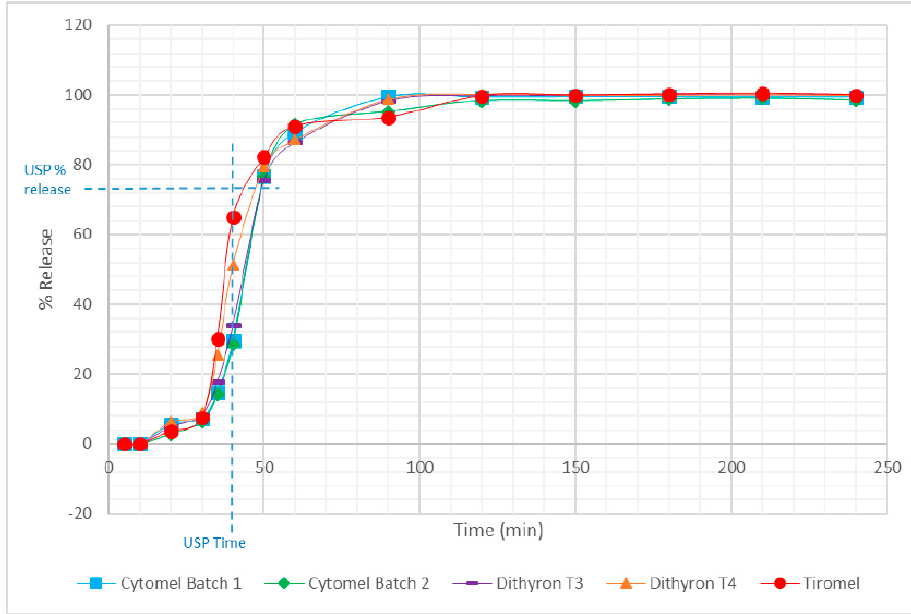
Figure 2. Dissolution testing profile for T3 and T4 from single- and dual-supplement thyroid hormone supplements.